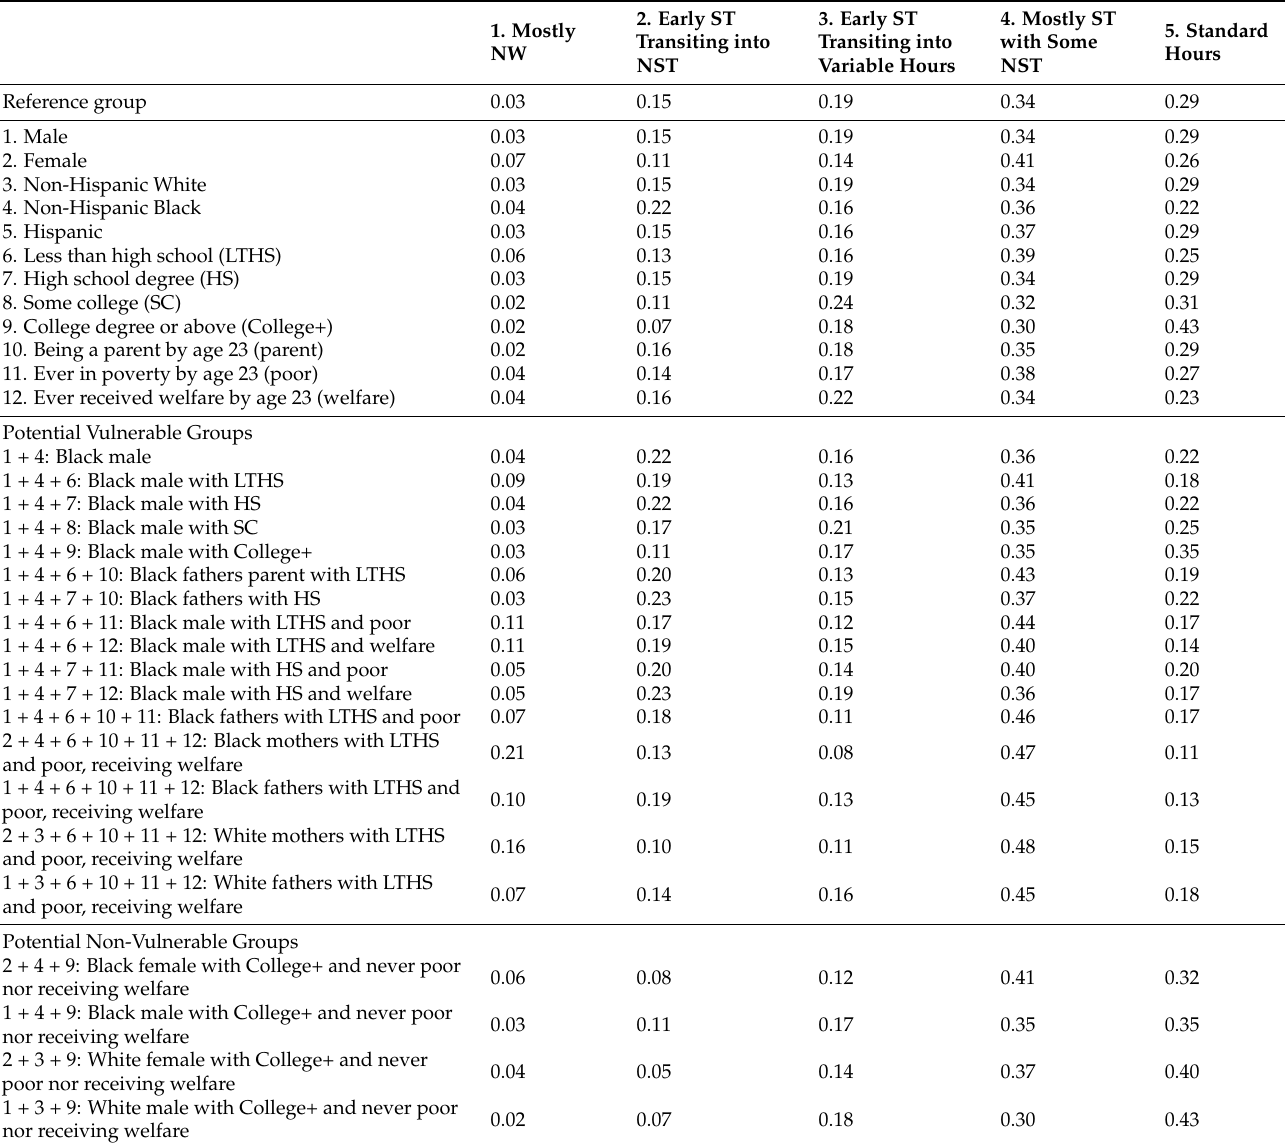
Table 3. Predicted Probability of Work Schedule Patterns by Various